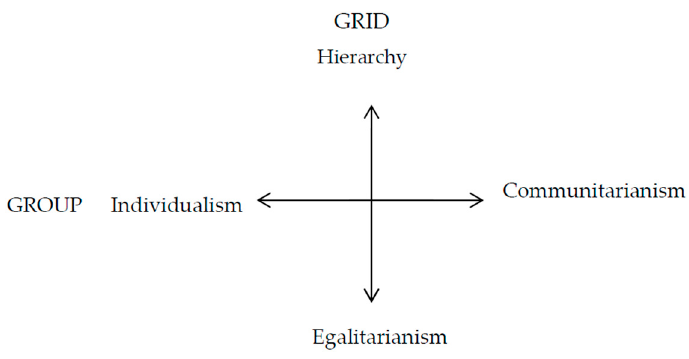
Figure 1. Douglas’ (1970) “grid-group” social type quadrant.